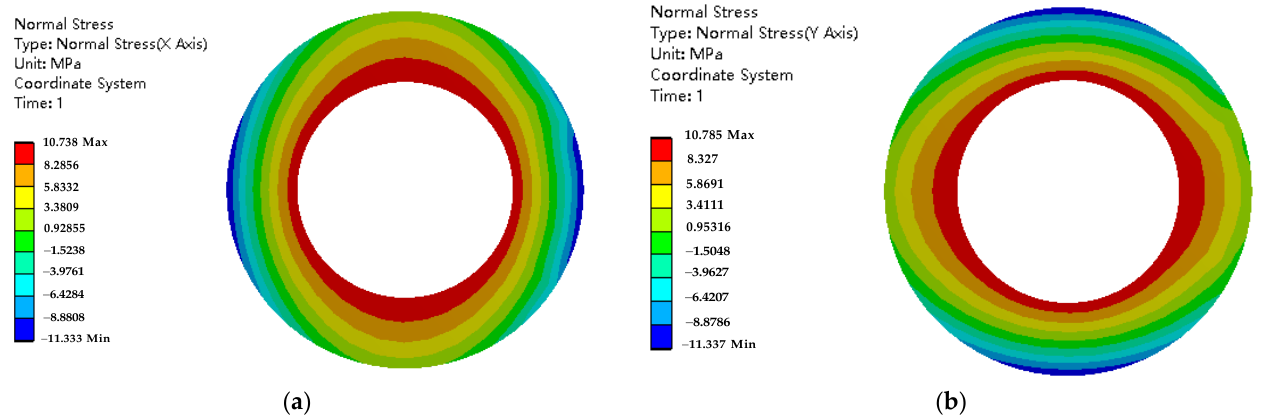
Figure 9. Stress results of the PM: ( a ) the PM stress in the radial direction (X-Axis); ( b ) the PM stress in the tangential direction (Y-Axis).